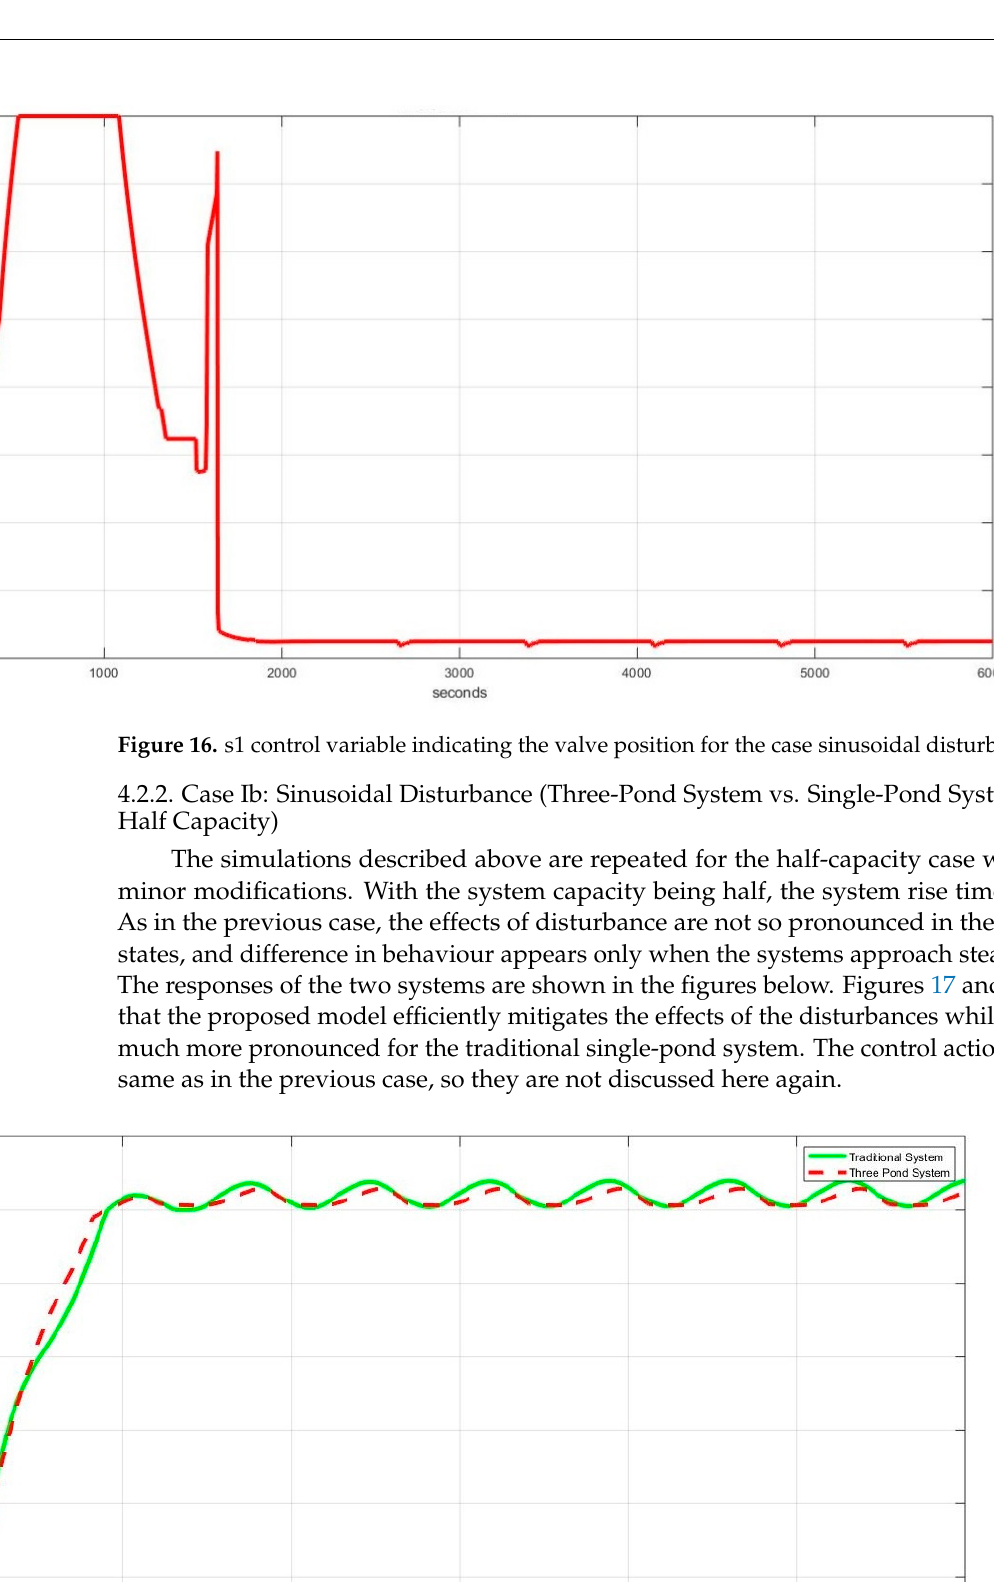
Figure 15. U1 control variable indicating the water inflow for case of sinusoidal disturbance.